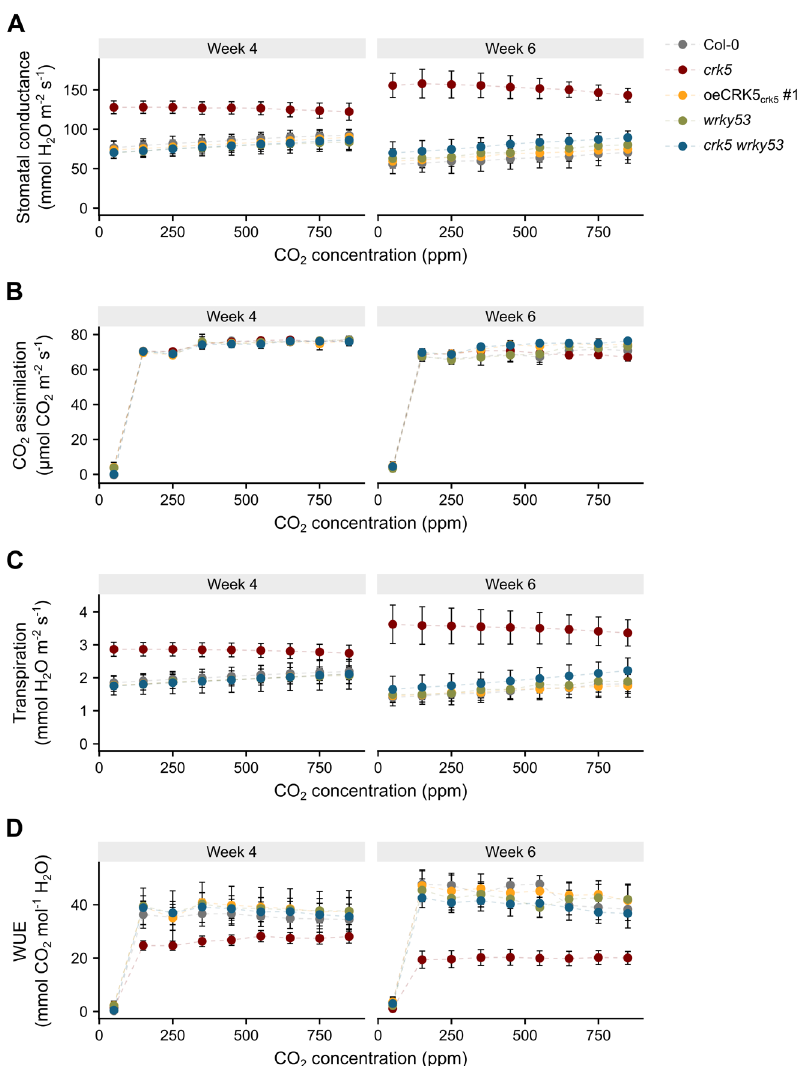
Figure 5. Foliar gas exchange characteristics in variable intercellular CO 2 concentration. The analysis involved 4-week-old and 6-week-old plants and was performed on CIRAS-3 Portable Photosynthesis System, with PAR of 300 µ mol m − 2 s − 1 and Cuvette Flow of 300 mL/min (A/Ci C3 ramp program). Individual charts represent ( A ) stomatal conductance, ( B ) CO 2 assimilation, ( C ) evapotranspiration, and ( D ) water use efficiency (WUE). Mean values ( ± SD) were derived from 8 plants ( n =